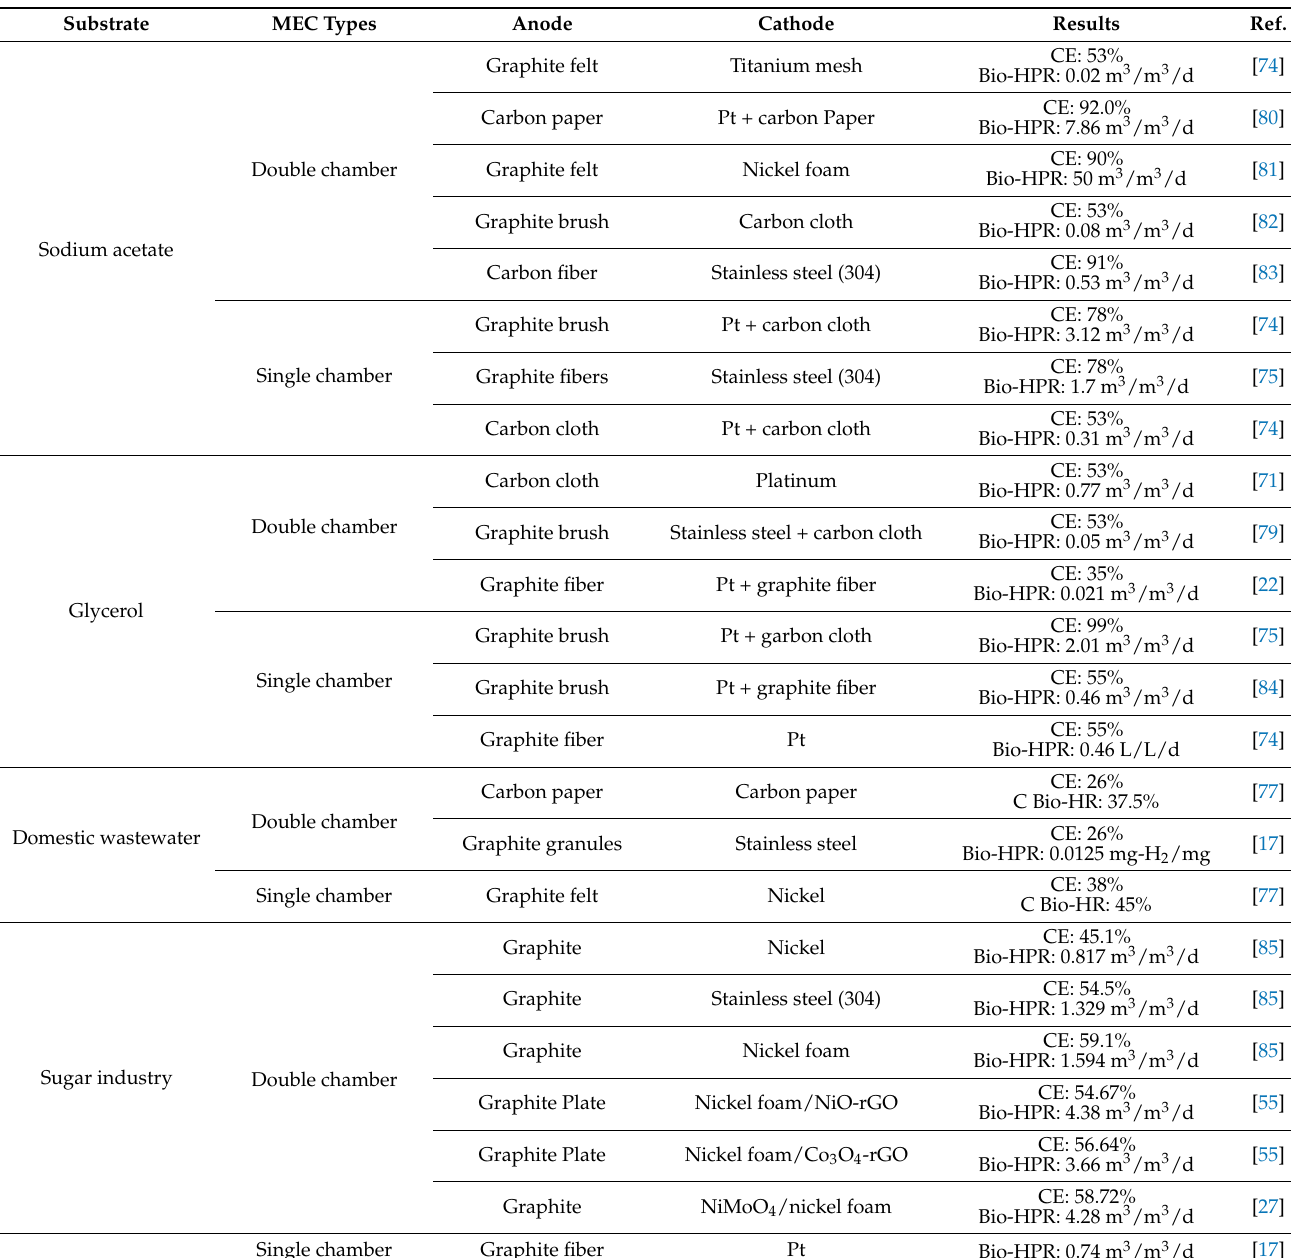
Table 3. Effect of substrates on performance of